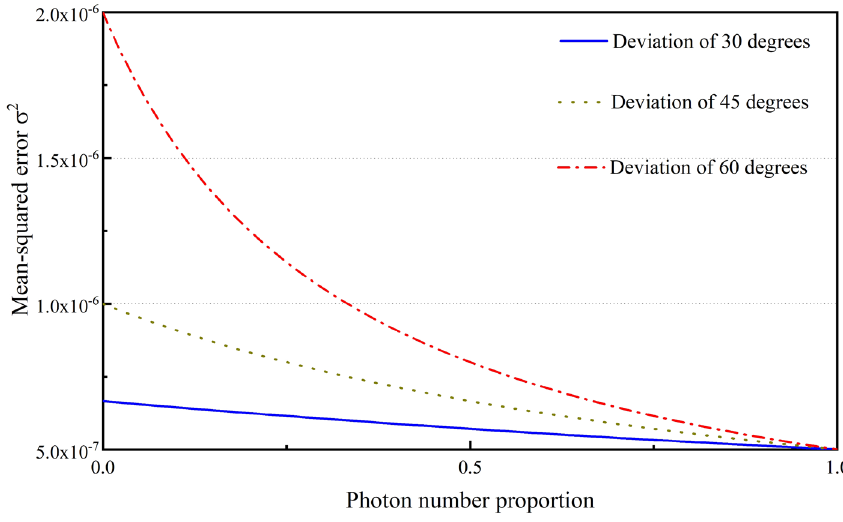
Figure 3. Dependence of MSE σ 2 on the ratio of the number of photons at detector 2 in the time delay detection, where the ratio of the number of photons is κ